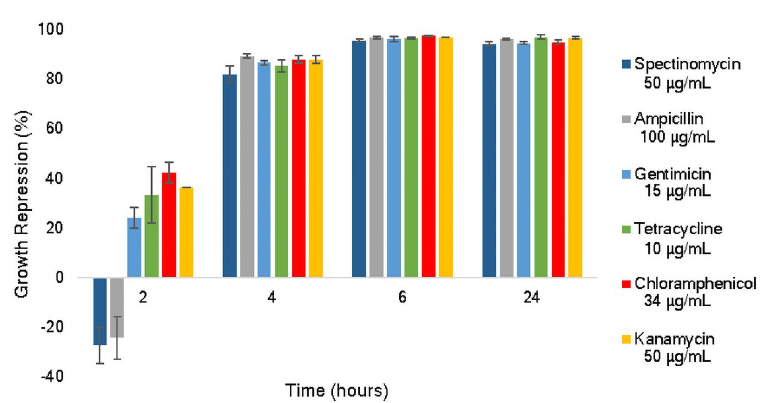
Fig 1. Antibiotic screening. Antibiotic in liquid medium with wild type A . succinogenes shown as percent repression of normal growth. Error bars represent one standard deviation.